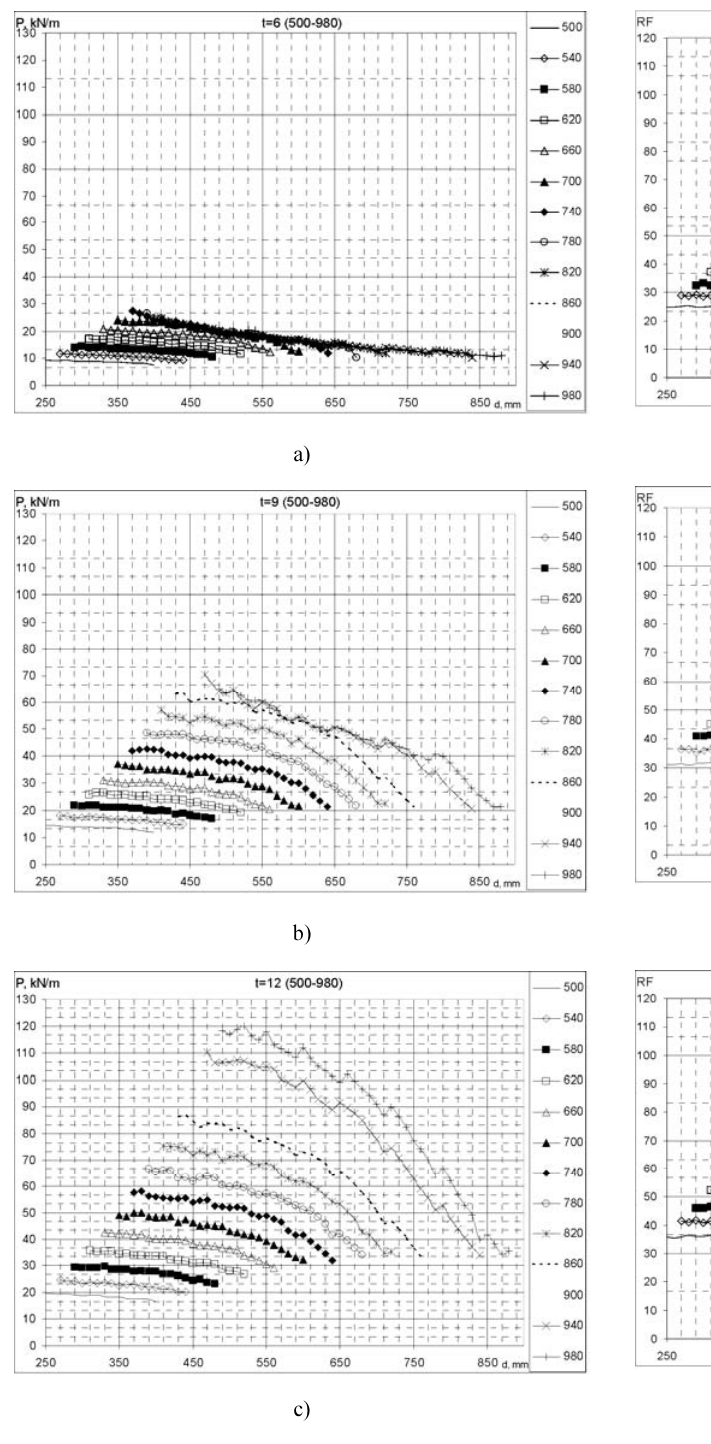
Fig. 5. Dependence of p versus d : a) for w t = 6 mm; b) for w t = 9 mm; c) for w t = 12 mm